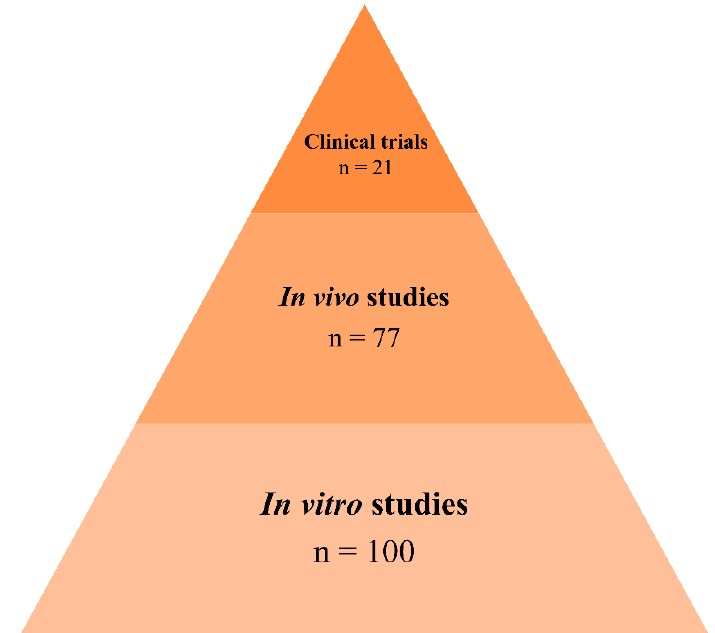
Figure 11. Number of natural products studied in different development phases.